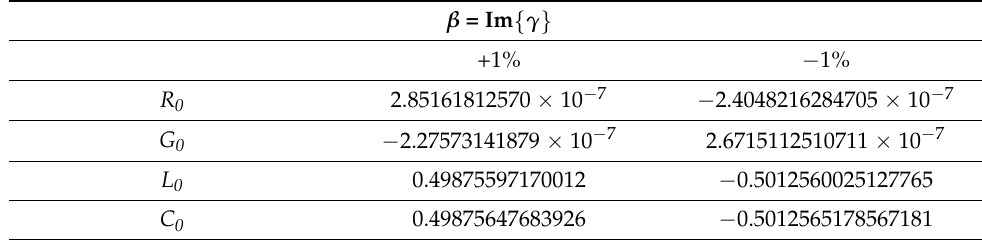
Table 3. Changes to phase constant.